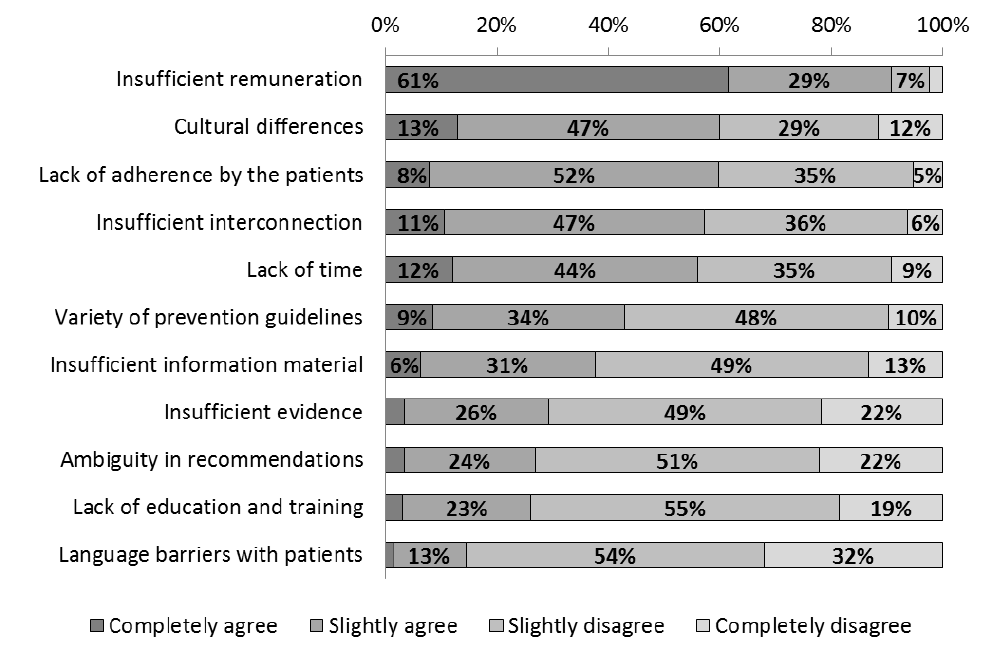
Figure 3. Obstacles to the provision of lifestyle advice in a general practitioner setting (% of